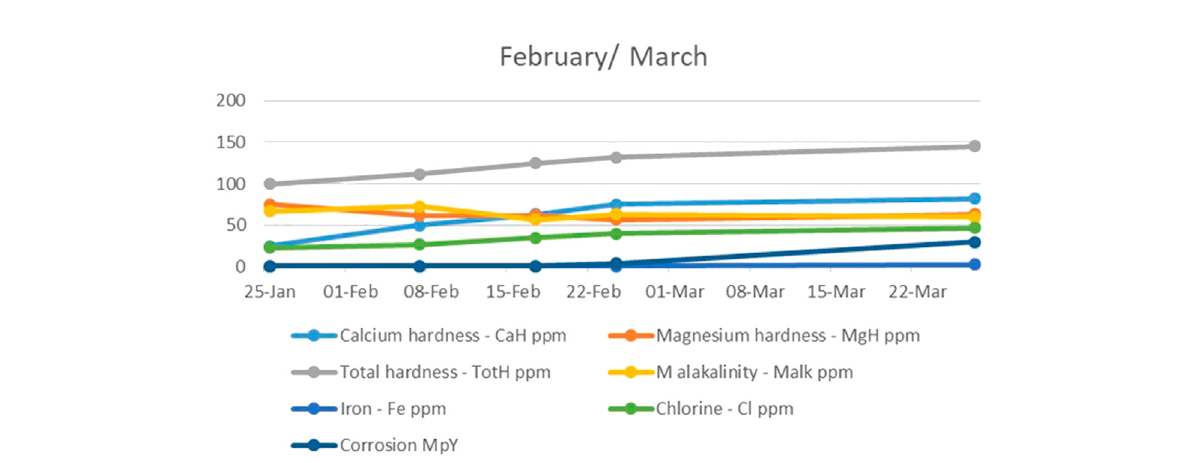
FIGURE 3 The trend of calcium and magnesium hardness, total hardness, alkalinity, iron, chlorine, and corrosion during the second and third month.